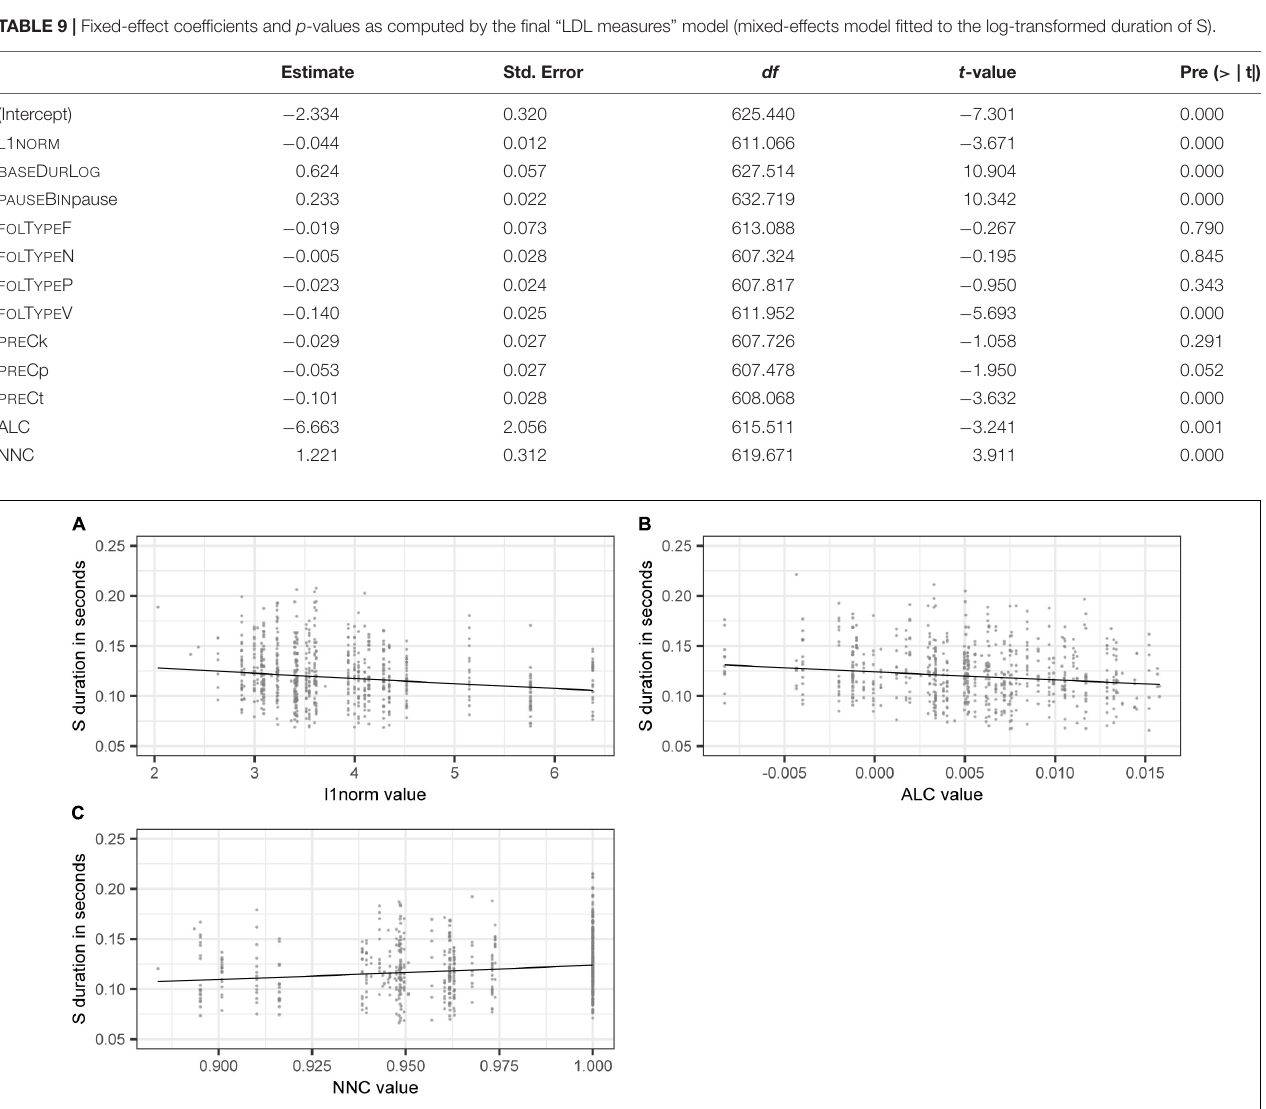
FIGURE 5 | Partial effects of LDL derived variables contained in the final “LDL measures only” model, fitted to the log-transformed values of duration of S. (A) L 1 NORM (B) ALC (C)